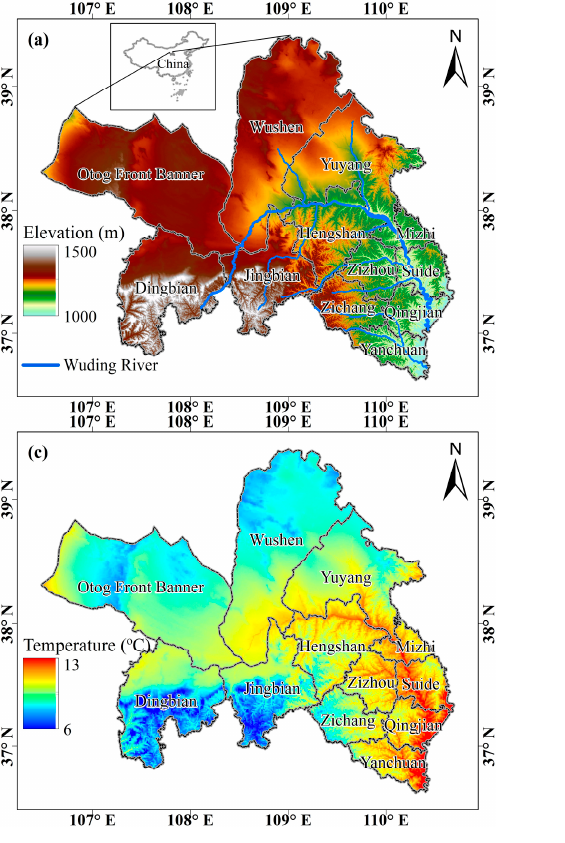
Figure 1. Spatial patterns of elevation ( a ), vegetation leaf area index ( b ), annual mean temperature ( c ) and annual total precipitation ( d ) in the Wuding River watershed.